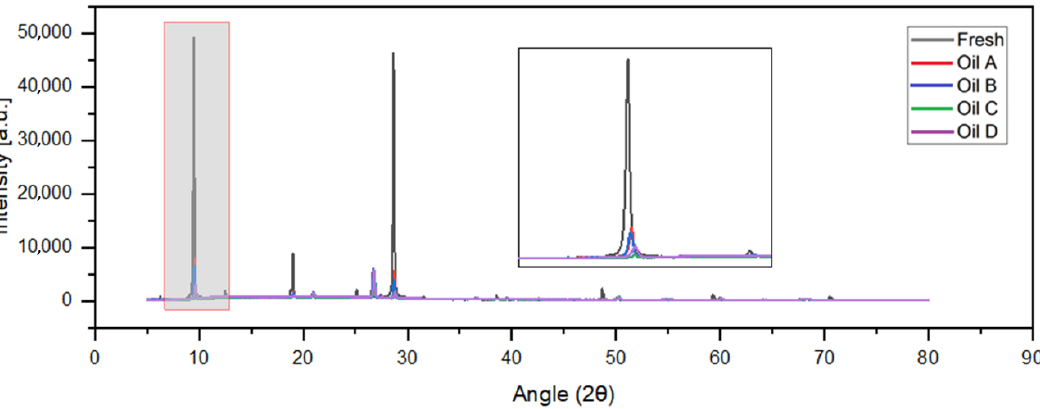
Figure 7. XRD spectra expressed in arbitrary units (a.u.) for the silicone (fresh and after 168 h of aging).